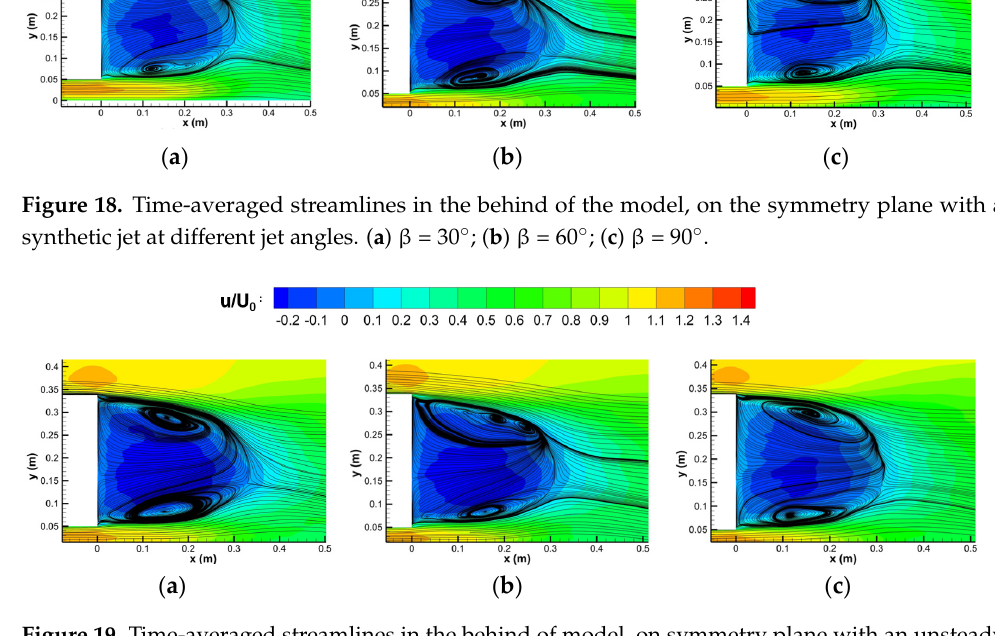
Figure 19. Time-averaged streamlines in the behind of model, on symmetry plane with an unsteady jet at different jet angles. ( a ) β = 30 ◦ ; ( b ) β = 60 ◦ ; ( c ) β = 90 ◦ . The normalized streamwise velocity profiles at the position x/H = 0.5 on the symmetry plane (z = 0) for various jet angles of actuated flows are plotted in Figure 20. The evolution of the negative streamwise velocities concerning the jet angles with different control techniques is consistent with the drag coefficients obtained in Table 2 and the streamlines analysis in Figures 17–19. The most significant limitation of backward flow occurs at a jet angle of 45° with steady blowing and unsteady jets, whereas this happens at 60° when the synthetic jet is used.